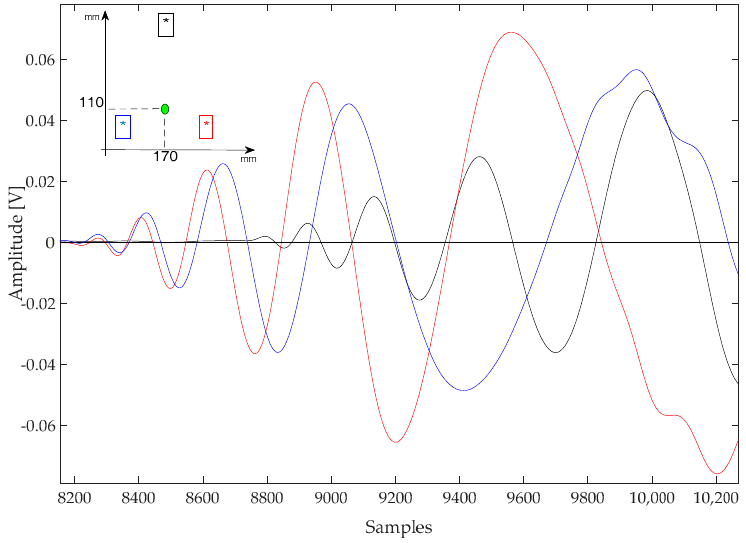
Figure 7 . Signal acquired with type A sensors during an impact at (170, 110) mm. Sampling rate 10 MSps.